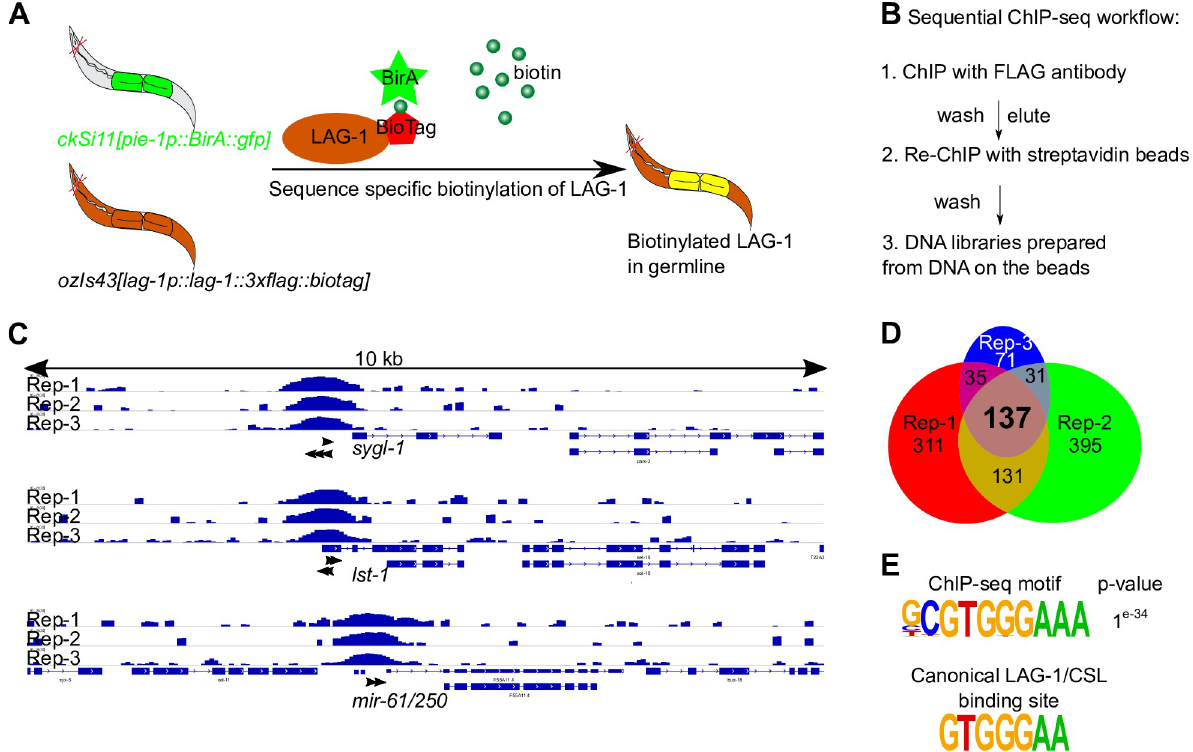
Fig 4. Genome-wide identification of germline-specific LAG-1 targets by sequential ChIP-seq. (A) Schematic showing BirA specifically expressed in the germline (in green) biotinylating LAG-1 containing the BioTag. The strain harbored two transgenes, i) ckSi11[pie-1p :: BirA :: gfp] , where biotin ligase BirA was driven by germline specific promoter pie-1 , and ii) ozIs43[lag-1p :: lag-1 :: 3xFLAG :: BioTag] ,see S1 Table. (B) The workflow of sequential ChIP-seq. Direct ChIP was not feasible due to the interference by high levels of endogeneous biotinylated proteins [53,54].Sequential ChIP-seq was developed to overcome this issue and to facilitate DNA library preparation from ultra-low amount of DNA. (C) Genome browser tracks for sygl-1 , lst-1 and mir-61/250 after sequential ChIP-seq. The raw reads were normalized to the control, and the signals are presented as log2-fold change after normalization. Black arrows, canonical LAG-1/CSL binding motif GTGGGAA [16,18,19]. See S4 Table . (D) Venn diagram showing 137 genes were overlapped from three biological replicates of germline LAG-1 ChIP-seq analyses. Rep, replicate. (E) The over-represented motif discovered by HOMER suite with germline specific ChIP-seq data (top) and the reported canonical LAG-1/CSL binding motif (bottom) [16,18,19].